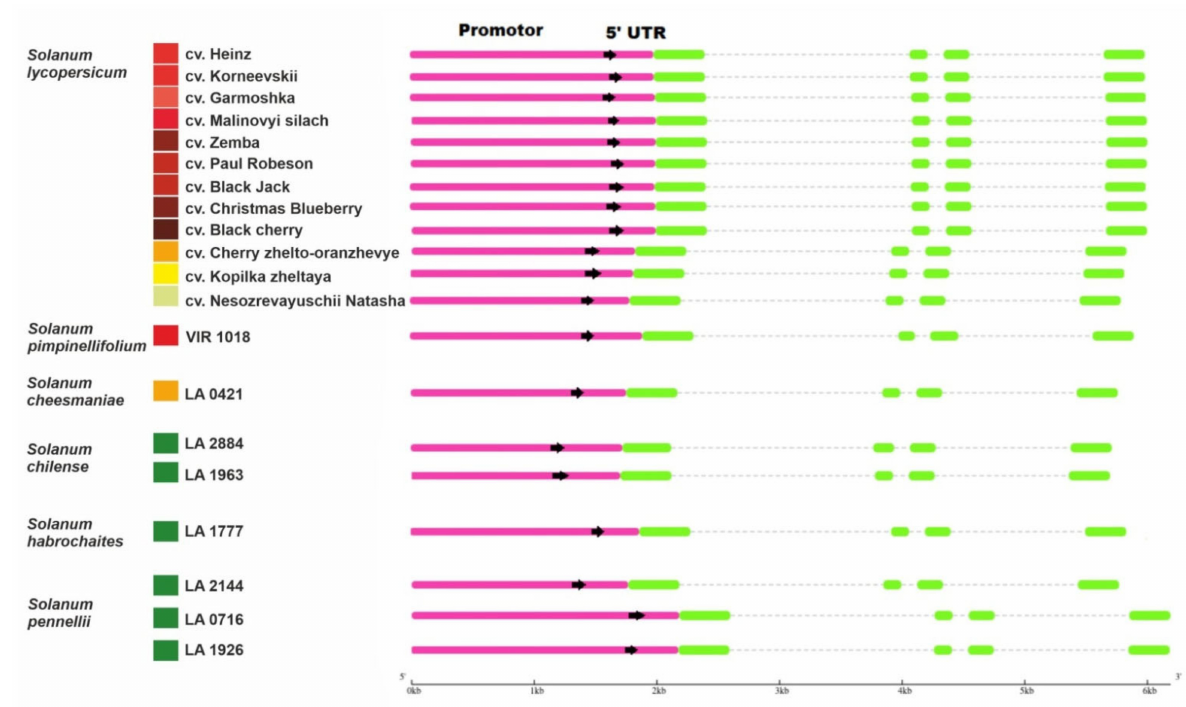
Figure 1. Structures of the identified Z-ISO homologous genes in Solanum lycopersicum cultivars and wild tomato species ( Solanum section Lycopersicon). Boxes indicate promoters/5 (cid:48) -UTRs (pink) and exons (green). The colored squares on the left edge of the picture indicate the color of the ripe fruit. Table 2. Variability of Z-ISO genes in S. lycopersicum cultivars and wild tomato species. Variability Gene Region/Translated Product